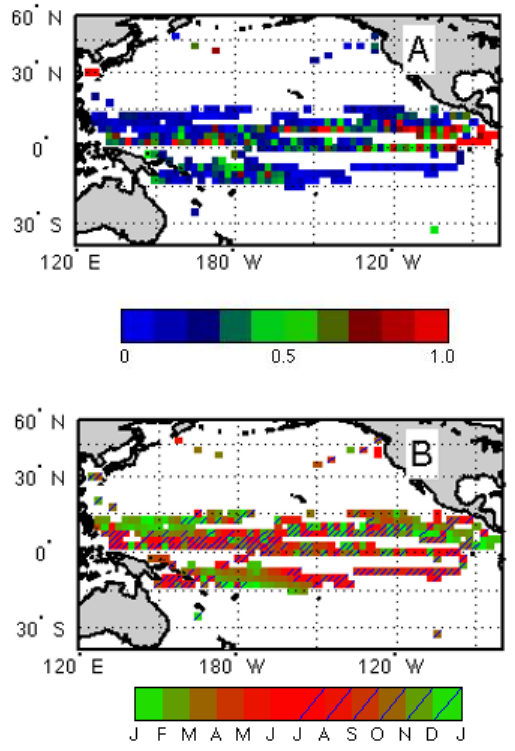
Fig. 8. (a) Amplitude of the u 0 ·∇ S term in Eq. (2). Color scale is shown with units 10 − 7 psss − 1 . (b) Phase of the u 0 ·∇ S term in Eq. (2). Color scale is shown indicating month of maximum value of the u 0 ·∇ S term. White or blank areas over the ocean indicate that enough data existed, but no significant seasonal cycle was